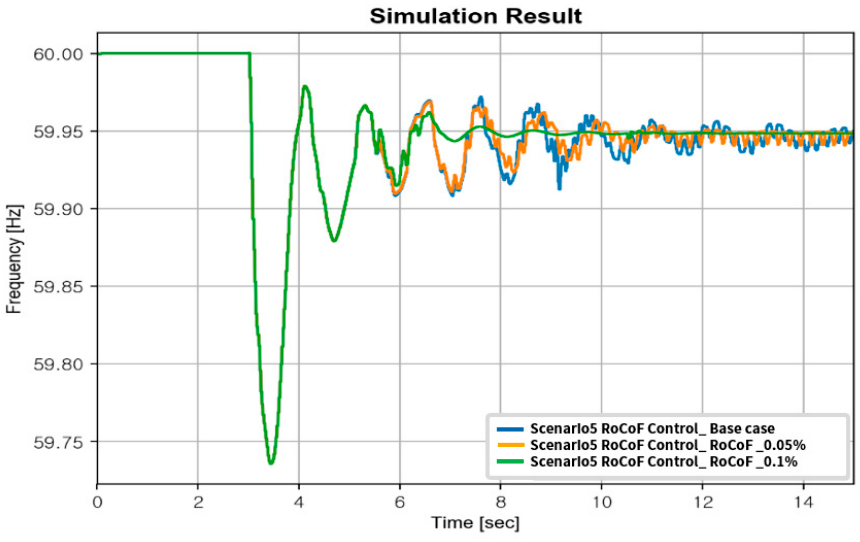
Figure A1. Frequency response by ESS parameter (RoCoF for trans-state). During the droop speed adjustment, the faster the ESS operation was performed, the frequency nadir increase effect was shown, but oscillation occurred during the frequency recovery process. In addition, the slower the ESS operation through the droop speed adjustment, the lower the oscillation and the frequency stabilized.